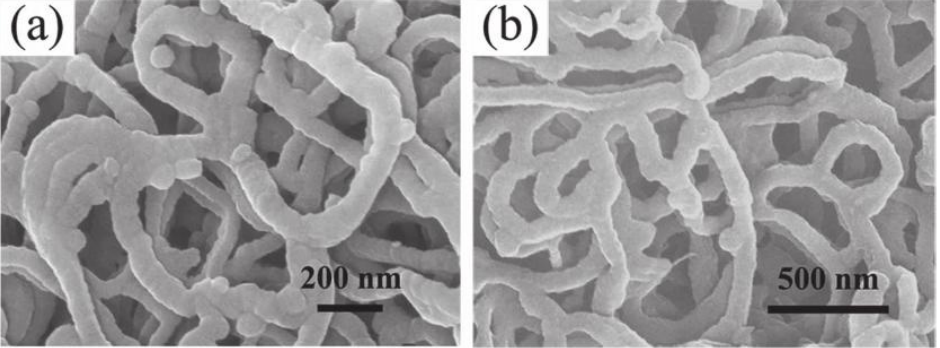
Figure 13. The SEM microstructure of the ( a ) PPy nanofiber webs and ( b ) CNF webs [82].